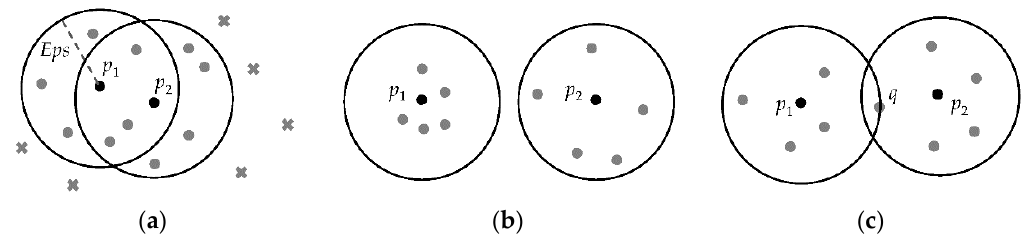
Figure 2. ( a ) Principle of the Density-Based Spatial Clustering of Applications with Noise (DBSCAN); ( b ) density calculation for the core points; ( c ) two clusters share a common point.